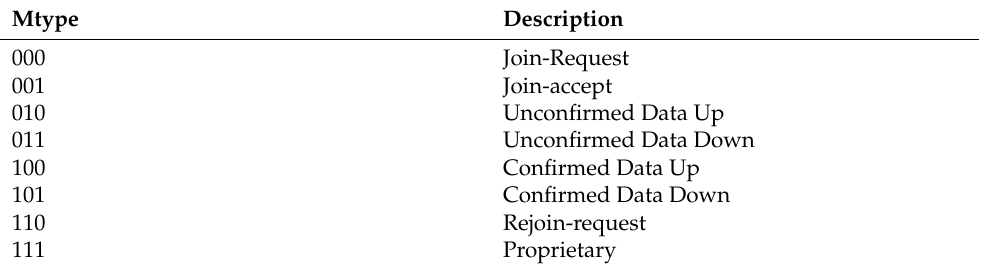
Table 3. MAC message